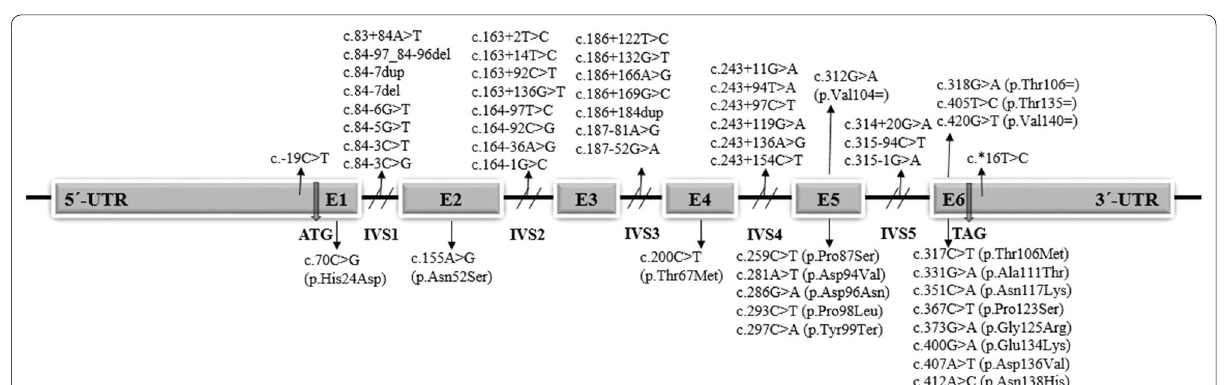
Fig. 1 Position of PTS gene variants reported among Iranian population (the genomic structure of PTS gene was adapted from Himmelreich et al.,